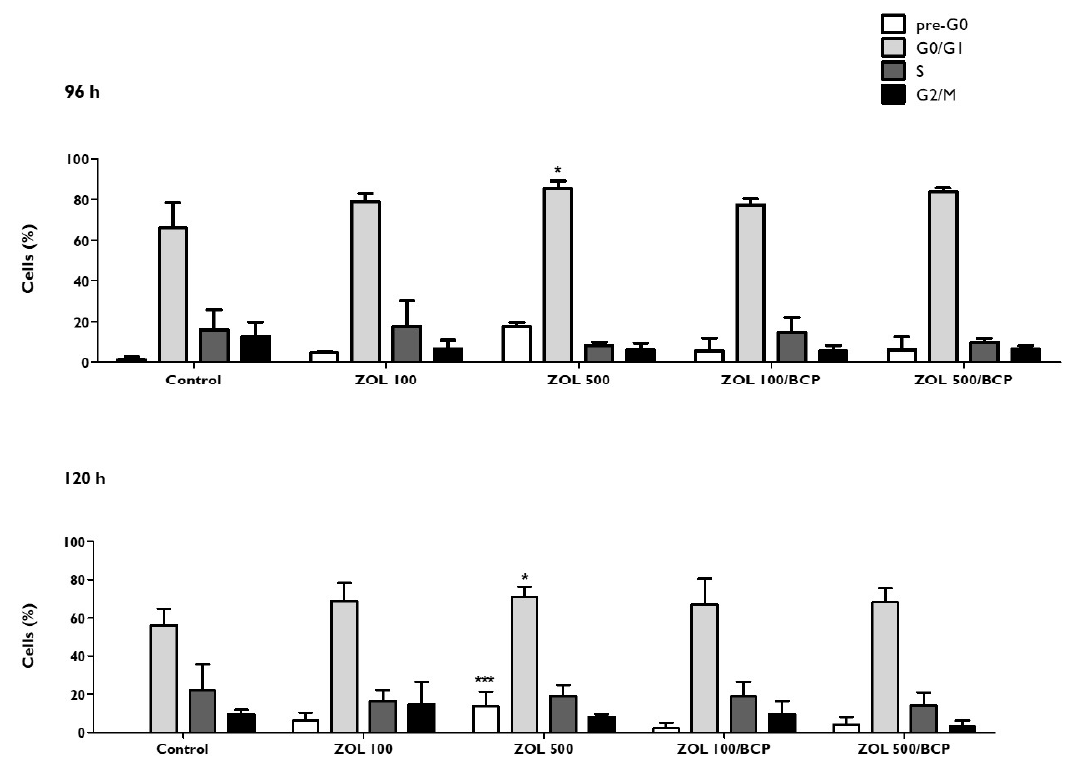
Figure 7. HGF cell cycle, 96 h and 120 h after treatment with ZOL and with ZOL/BCP. The results represent the mean and standard deviation of at least three tests. Significant differences are represented with *, where * means p < 0.05, ** means p < 0.01, and *** means p < 0.001.